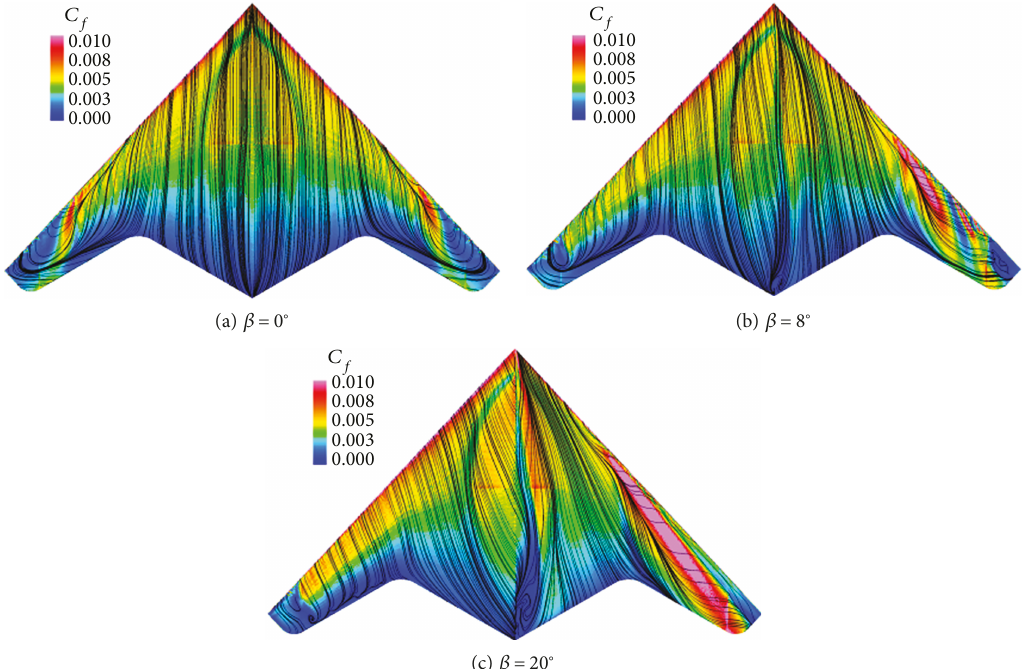
Figure 13: Skin friction lines and skin friction contours at angle of attack 12 °